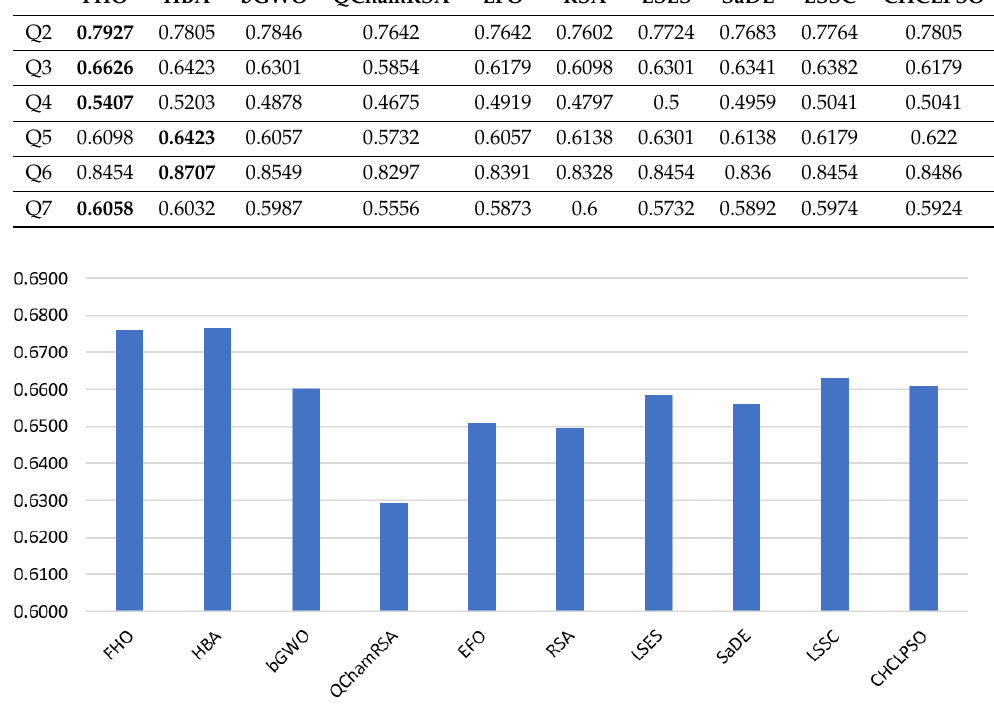
Figure 5. Average of the accuracy measure for the multi-class experiment. Table 9. Precision results for the multi-class experiment.